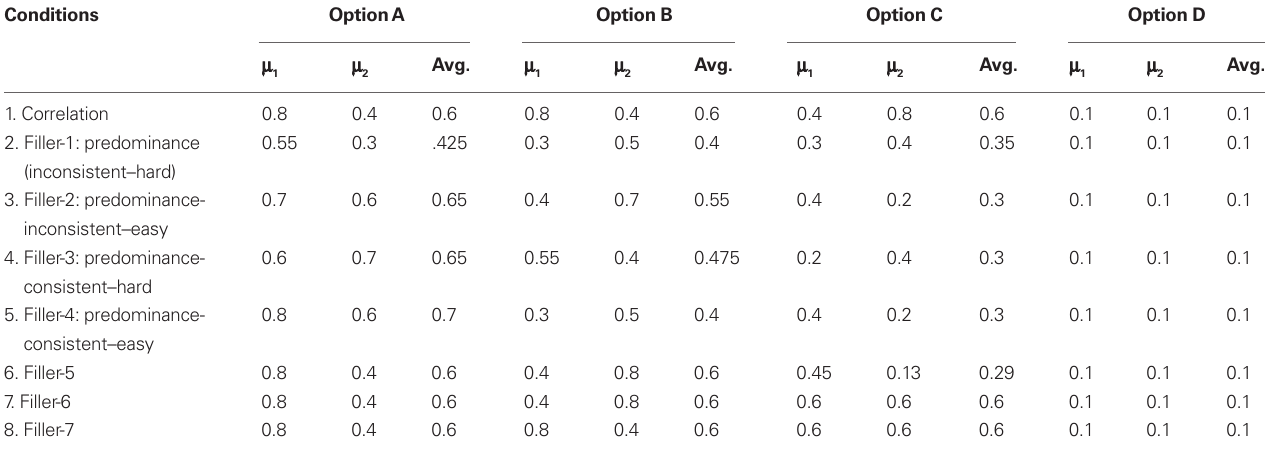
Table A1 | experimental conditions.